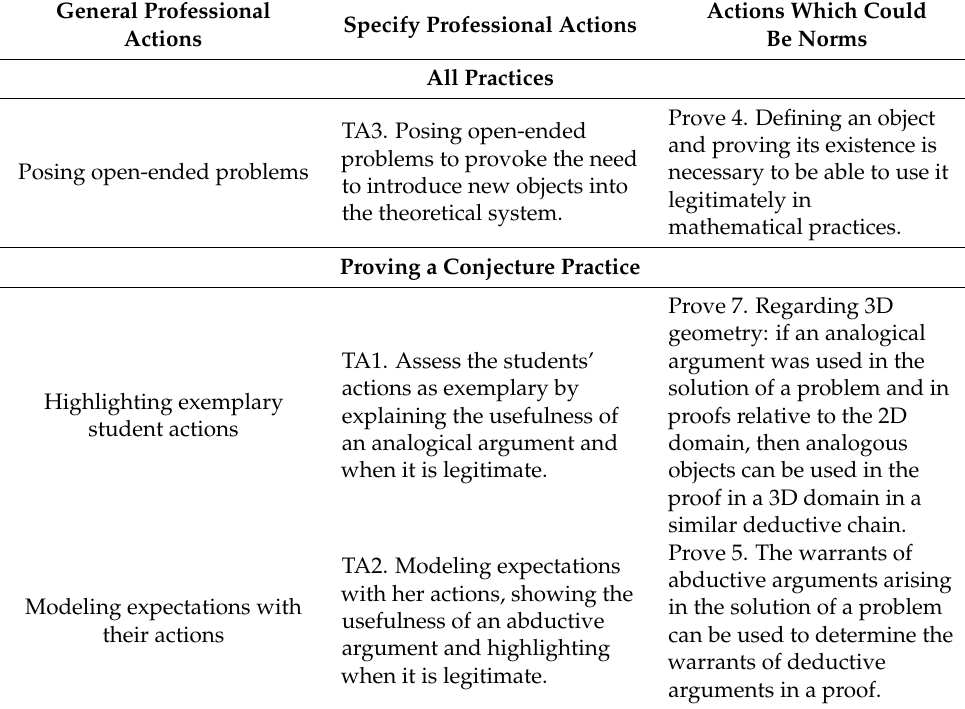
Table 5. Professional actions and actions which could be norms in Episode C.